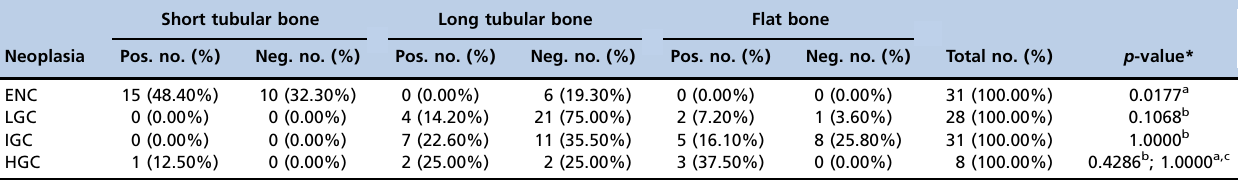
Table 2 - Amphiregulin expression status by topography. Short tubular bone